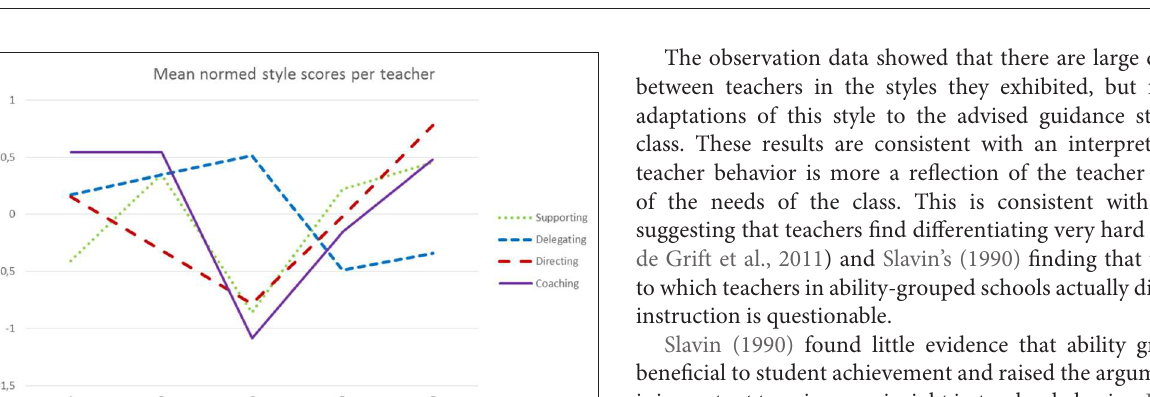
styles. To our knowledge, empirical evidence supporting the transition from a test to a guidance style is missing, both in education and more in general in the management literature. Further research is needed to differentiate between these three possible